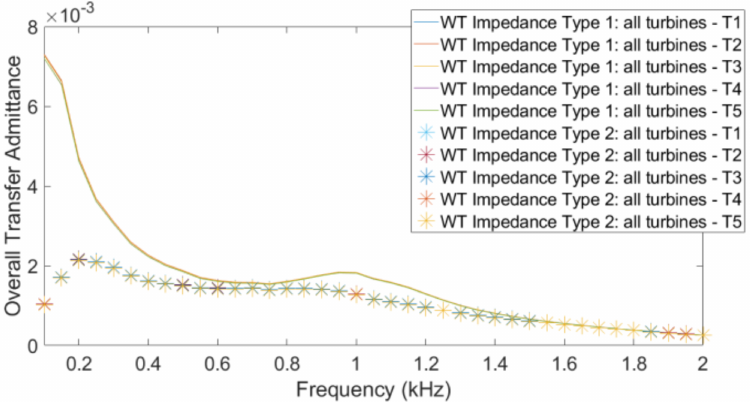
Figure 13. Impact of WT impedance on overall transfer admittance from all turbines to one turbine: 5-turbine wind power plant.